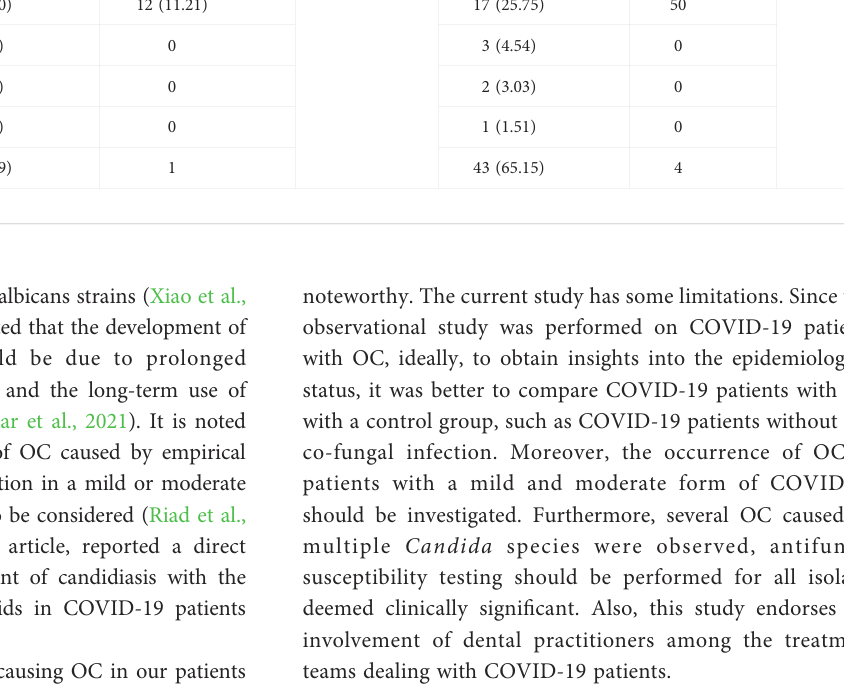
TABLE 3 Frequency of Candida species causing oral candidiasis in Patients Undergoing Treatment with Systemic corticosteroids and antibiotics versus Non-Users. Species